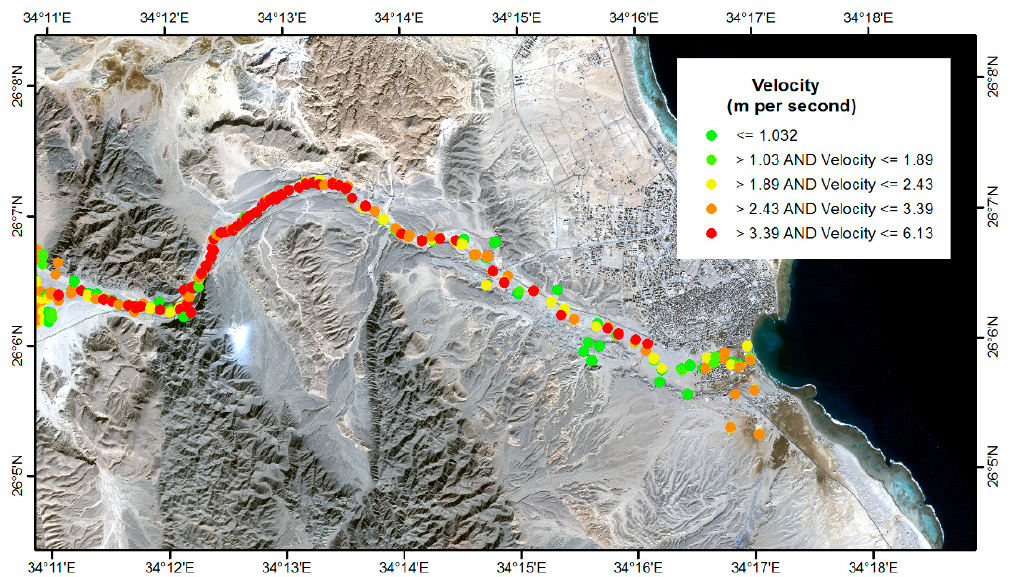
Figure 12. The modeled floodwater velocities along the main course of Wadi El-Ambagi. The flow velocity ranges between 1.03–6.13 m s − 1 , where high water velocities are observed along segments with a narrow channel course due to the concentration of surface